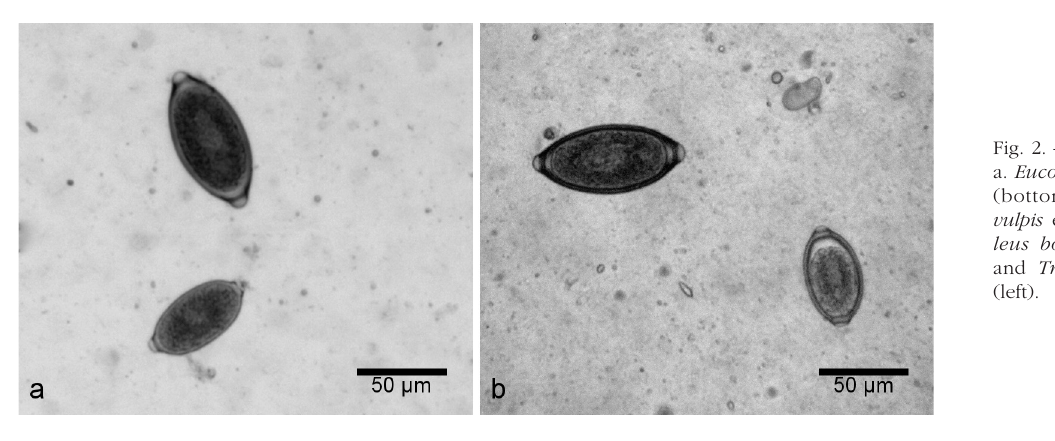
Fig. 1. – Light microscopy: a. Eucoleus boehmi egg; b. Eucoleus aerophilus egg; c. Trichuris vulpis egg.